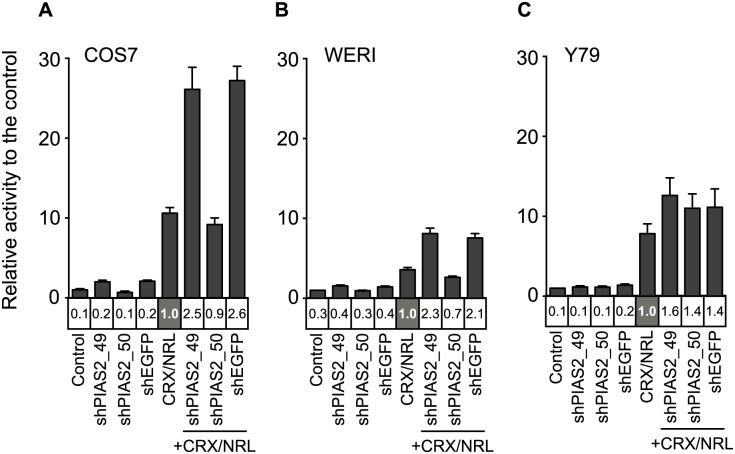
shRNA effect on rho-Gluc activity varies depending on the cell lines transfected.Transfection assay with rho-Gluc reporter and the indicated shRNAs with or without CRX and NRL expression vectors was performed in COS-7 (A), WERI (B), and Y-79 (C) cells. As a control, 500 ng of empty pcDNA3 vector with 100 ng reporter vector was transfected into the cells. Culture medium was collected two days after the transfection to measure Gaussia luciferase activity. Relative luciferase activity to the control (bar graph) and the CRX/NRL transfected sample (in the column under the bar graph) are presented. Error bars are shown as SE.